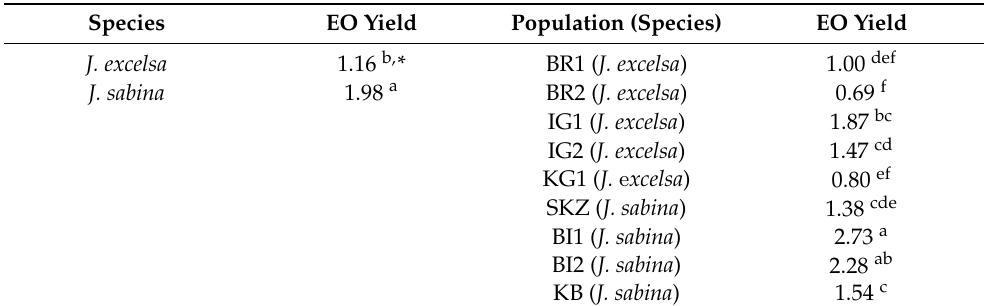
Table 2. Mean essential oil (EO) yield (%) obtained from the two species and the accessions nested in the